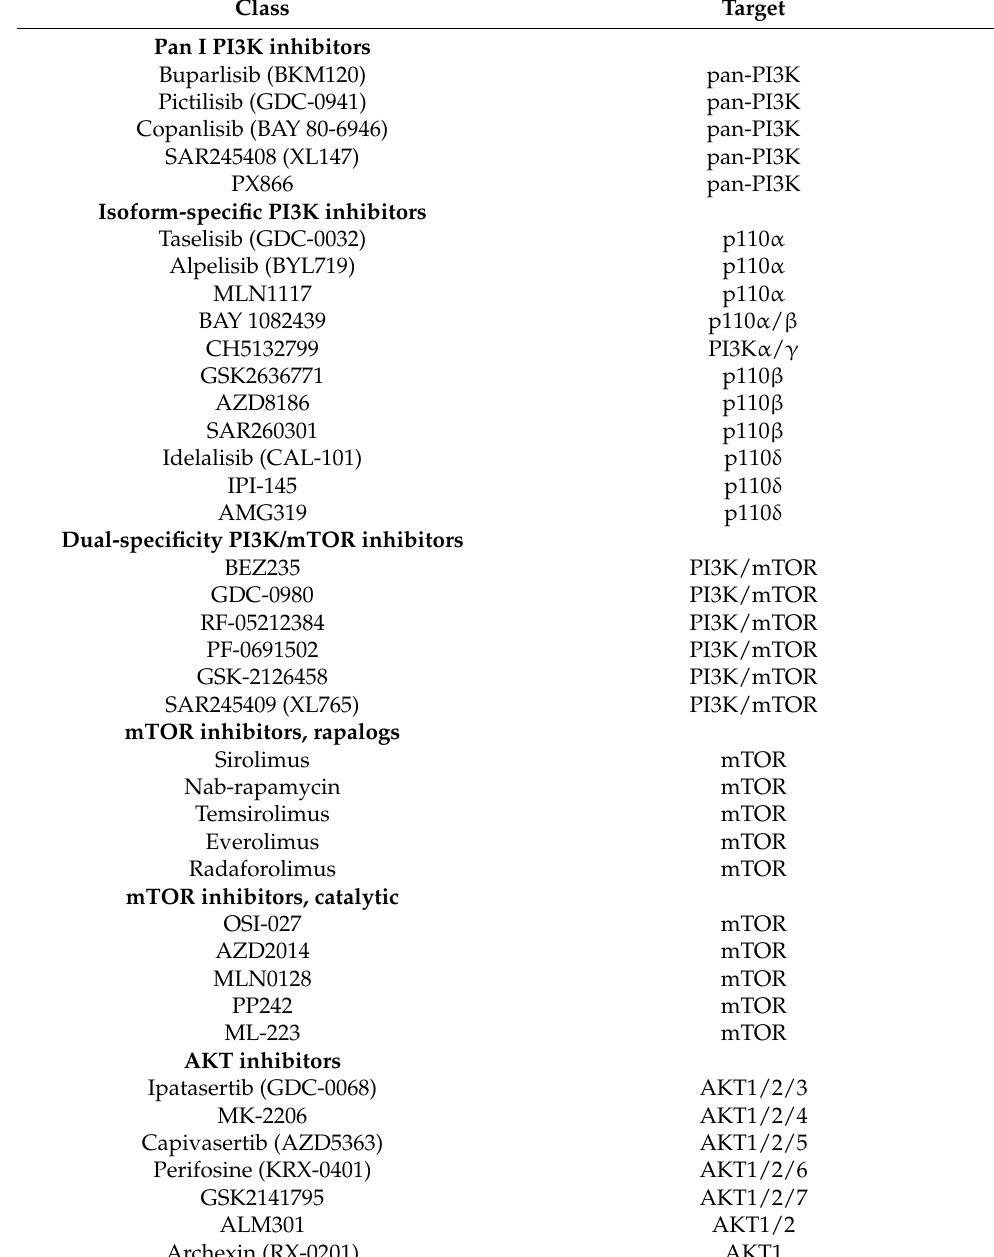
Table 1. PI3K/AKT/mTOR pathway